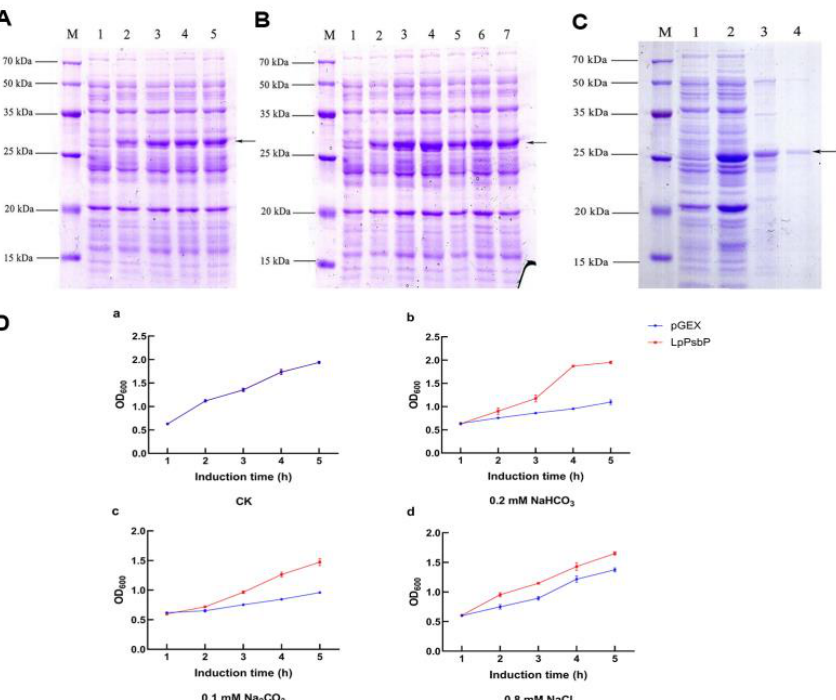
Figure 3. Protein induction experiment. ( A ): pGEX-LpPsbP induction at different IPTG concentra- tions (M: protein marker; 1, 2, 3, 4, 5: the expression of LpPsbP protein was induced by 0, 0.5, 1, 1.5, 2 mM IPTG); ( B ): pGEX-LpPsbP induction at different times (M: protein marker; 1, 2, 3, 4, 5, 6, 7: the expression of LpPsbP protein was induced for 0, 0.5, 1, 2, 3, 4, 5 h, respectively). ( C ): pGEX-LpPsbP protein purification using purification column with GST purification resin. M: protein marker; 1: induced without IPTG; 2: induced with 1 mM IPTG for 5 h; 3: pGEX-LpPsbP renatured protein; 4: pGEX-LpPsbP purified protein. ( D ): Growth curves of Escherichia coli under different saline – alkali stresses. a: The OD 600 values of pGEX and LpPsbP induced for 5 h under untreated conditions (CK). b: The OD 600 value of bacterial solution after 5 h induction by pGEX and LpPsbP under the treatment of 0.2 mM NaHCO 3 . c: The OD 600 value of bacterial liquid after 5 h induction by pGEX and LpPsbP under the treatment of 0.1 mM Na 2 CO 3 . d: The OD 600 value of bacterial solution after 5 h induction by pGEX and LpPsbP under the treatment of 0.8 mM NaCl.